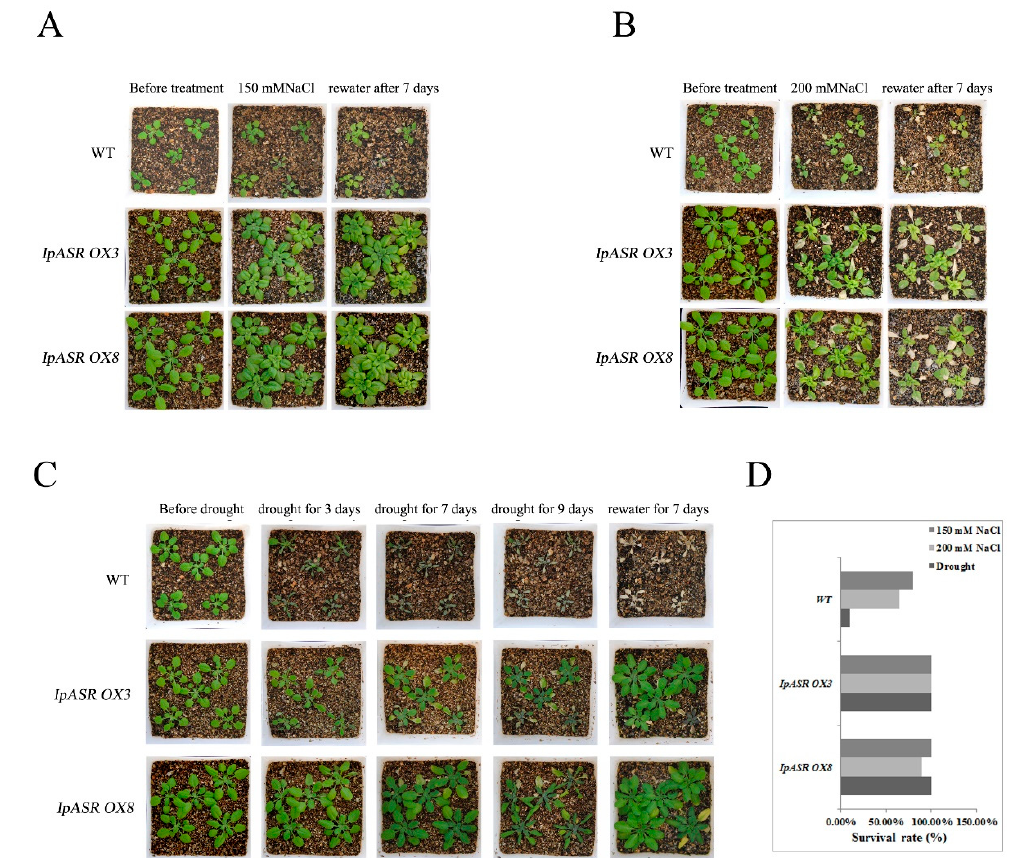
Figure 11. Photographs and survival rates of the transgenic overexpression lines and WT plants grown in pots under normal and salt/drought conditions. ( A ) The effects of 150 mM NaCl on transgenic lines and WT; ( B ) the effects of 200 mM NaCl on transgenic lines and WT; ( C ) the effects of withholding water on transgenic lines and WT. ( D ) The statistics for the survival rate of the transgenic lines and WT Arabidopsis after salt/drought stress. Thirty plants each of WT and two transgenic lines ( IpASR OX3 and IpASR OX8 ) were treated with various concentrations of NaCl or drought stress.